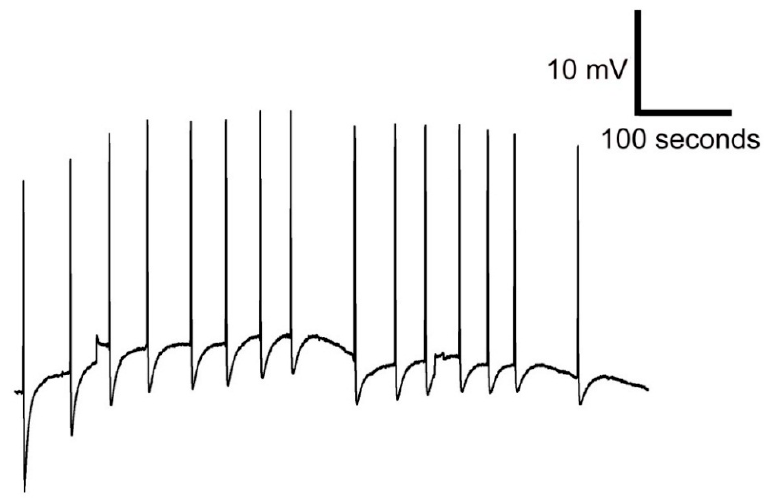
Figure 9. A series of action potentials of Venus flytrap in response to 15 touches of trigger hairs recorded by cotton fabrics coated with PPy+PANI.